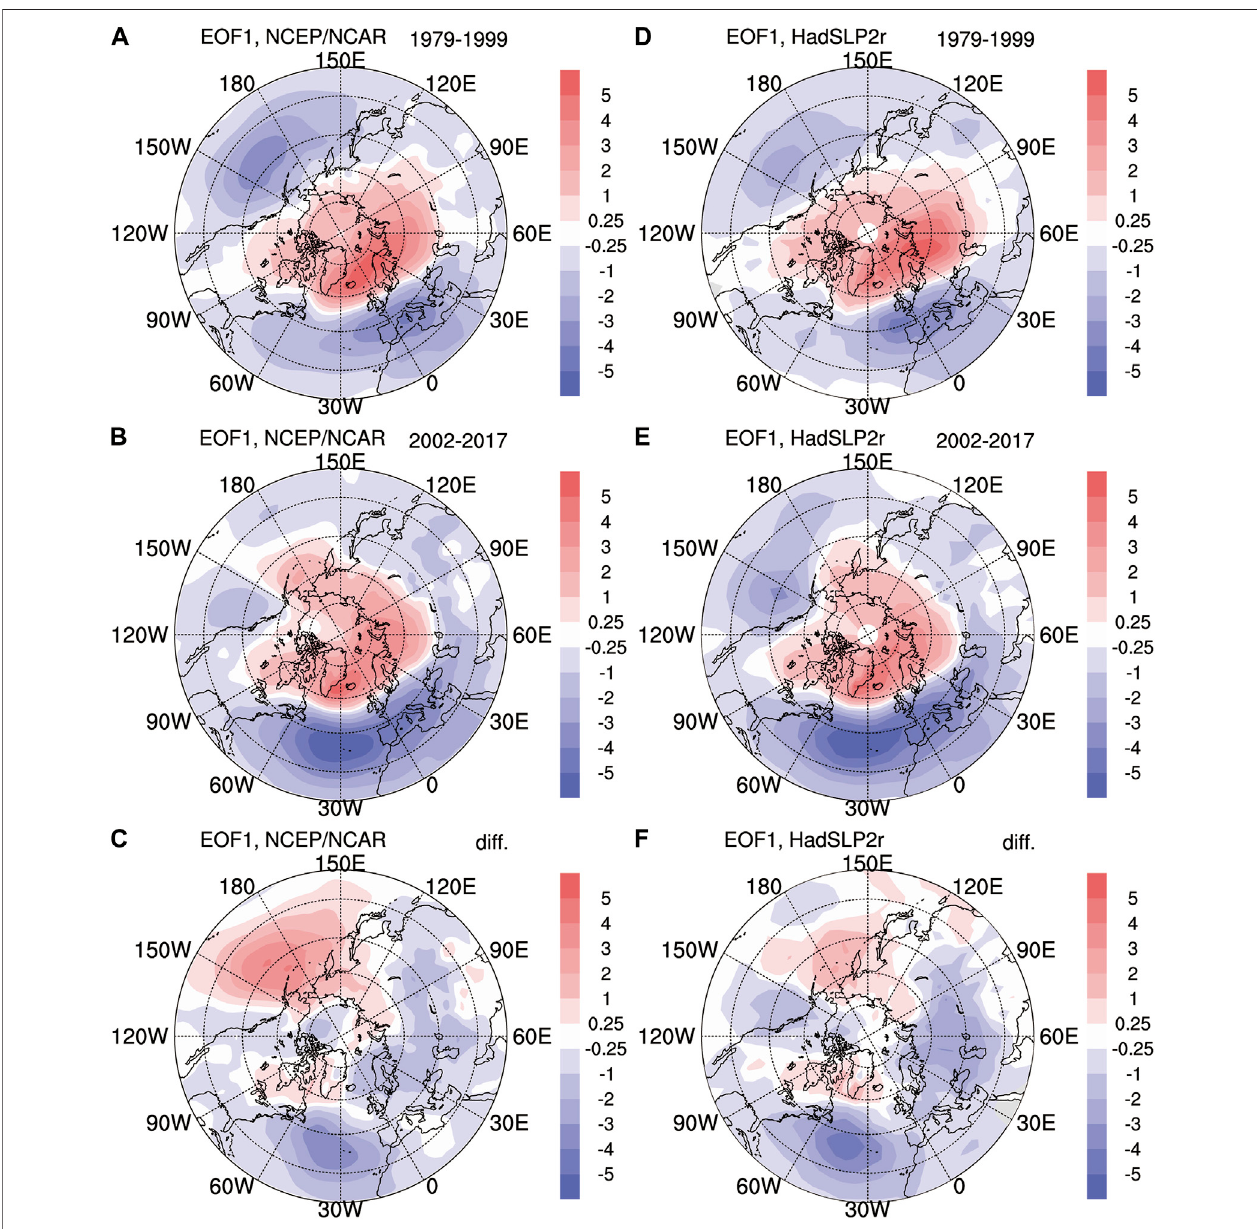
FIGURE 6 | (A, B, C) The leading EOF mode of SLP anomalies (units: hPa) north of 20 ° N during (A) 1979 – 1999 and (B) 2002 – 2017, and (C) their difference (2002 – 2017 minus 1979 – 1999). Anomalies are calculated based on the climatology of 1979 – 2017. The variance contribution of (A) and (B) is 38.1 and 31.2%, respectively. The SLP isderived from the NCEP/NCARdataset. (D, E,F) Asin (A, B, C) but for the results derived from the HadSLP2r data. The variance contribution of (D) and (E) is 38.5 and 31.4%, respectively.